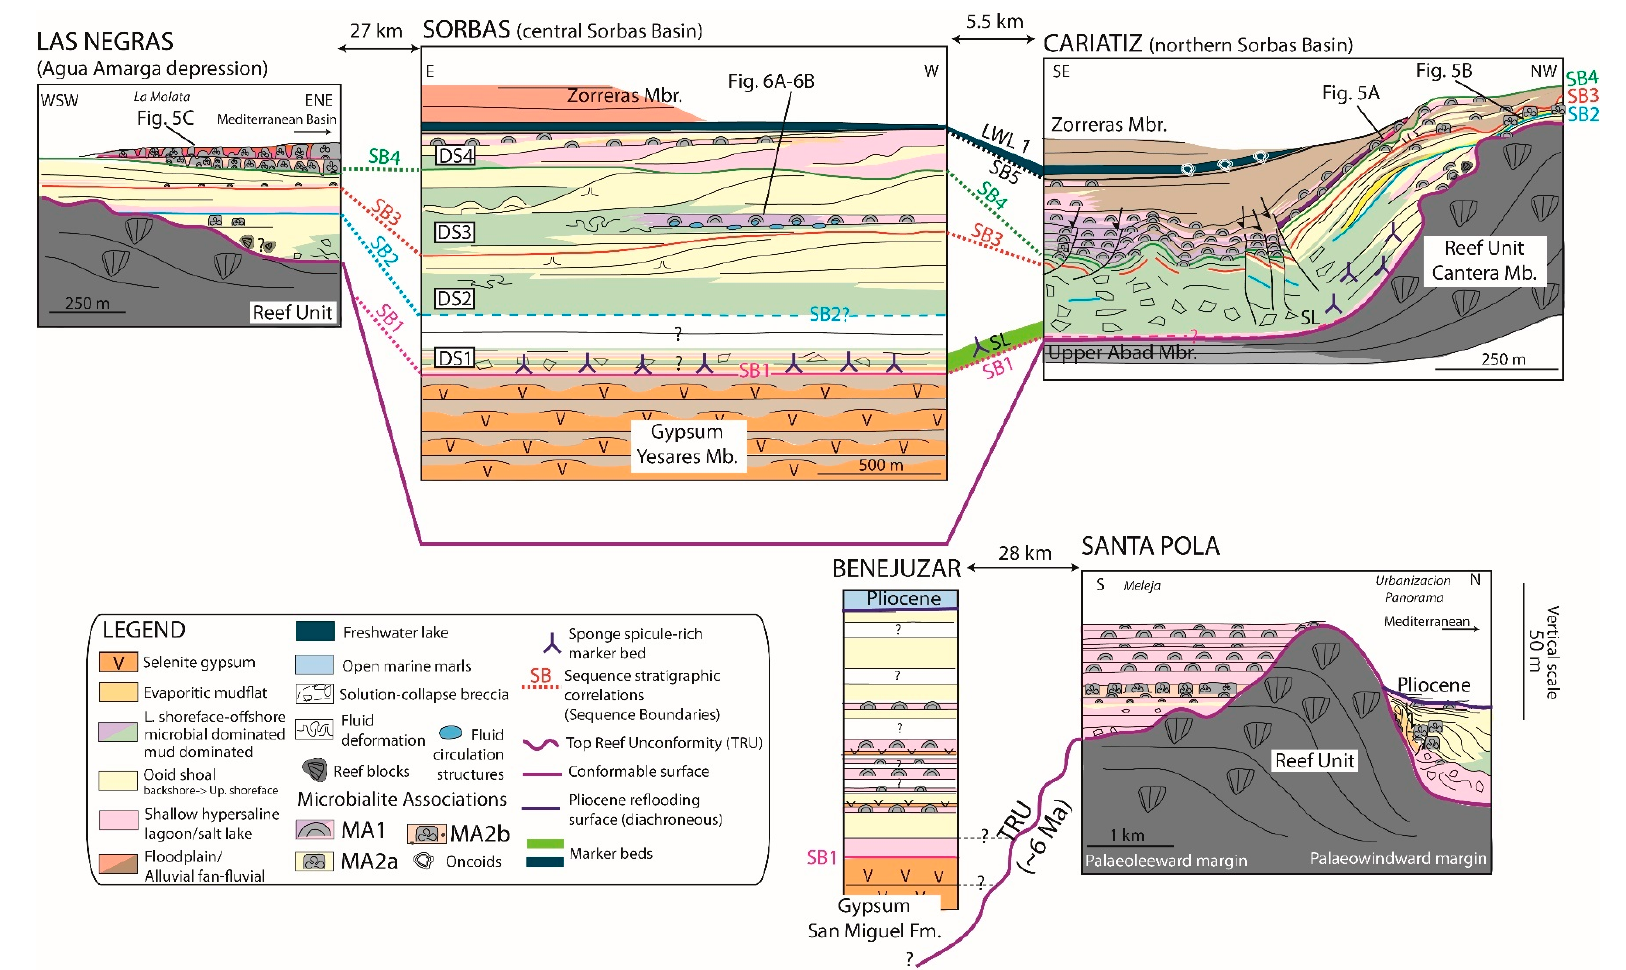
Figure 3. Depositional environments, stratigraphic architecture and correlations of the Terminal Carbonate Complex in the studied localities. The distribution of microbialite associations MA1, MA2a, and MA2b is represented on this scheme. The stratigraphy from Benejuzar is a synthesis of [43,44]. Mb. = Member; Fm. = Formation.